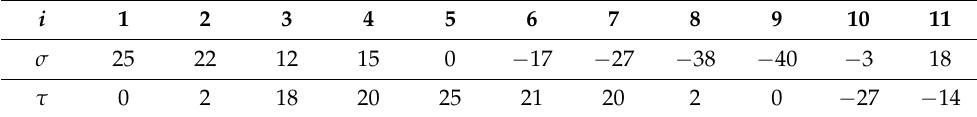
Table 5. Experimental data of the initial transformation onset of Ni–Ti SMA at − 10 ◦ C (unit: MPa).